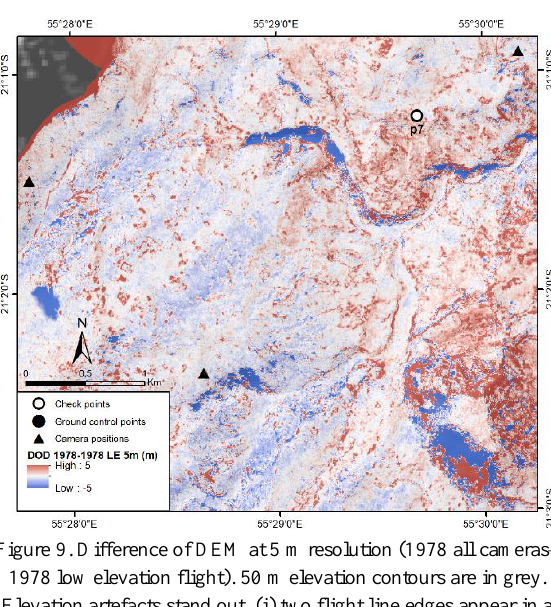
Figure 9. Difference of DEM at 5 m resolution (1978 all cameras– 1978 low elevation flight). 50 m elevation contours are in grey. Elevation artefacts stand out. (i) two flight line edges appear in a NW-SE direction about 1.1 km apart from one another; (ii) stripes striking SW to NE show oscillations of elevation at 200 – 500m